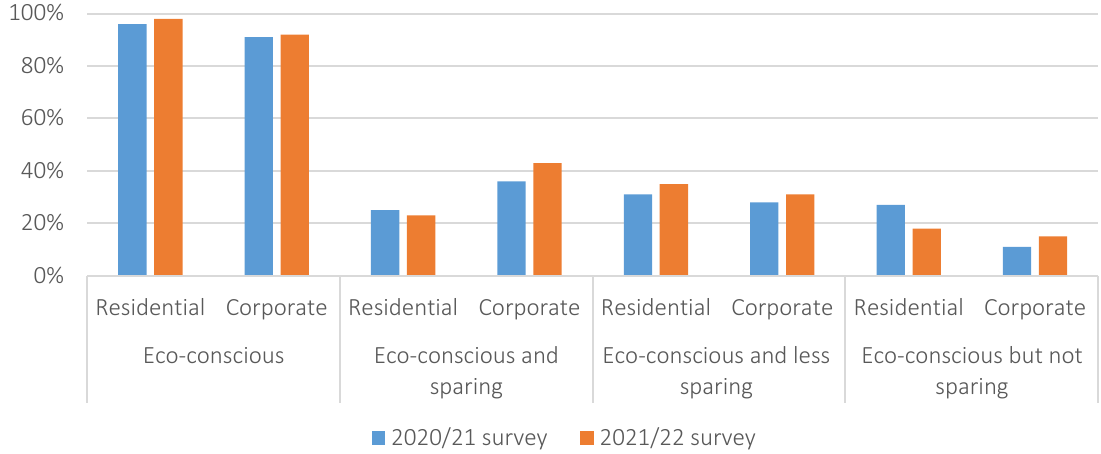
Figure 4. Eco-consciousness of residential and corporate